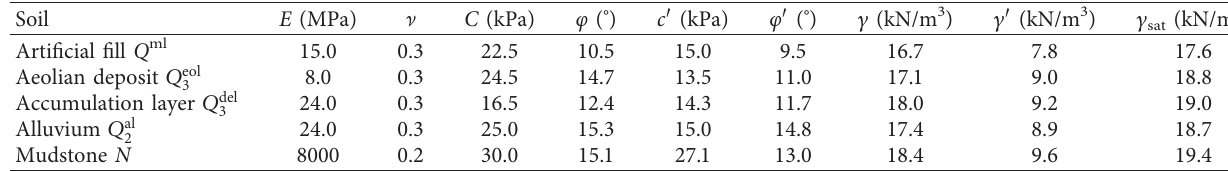
Figure 9: Slope profile. Table 4: The finite element calculation parameter